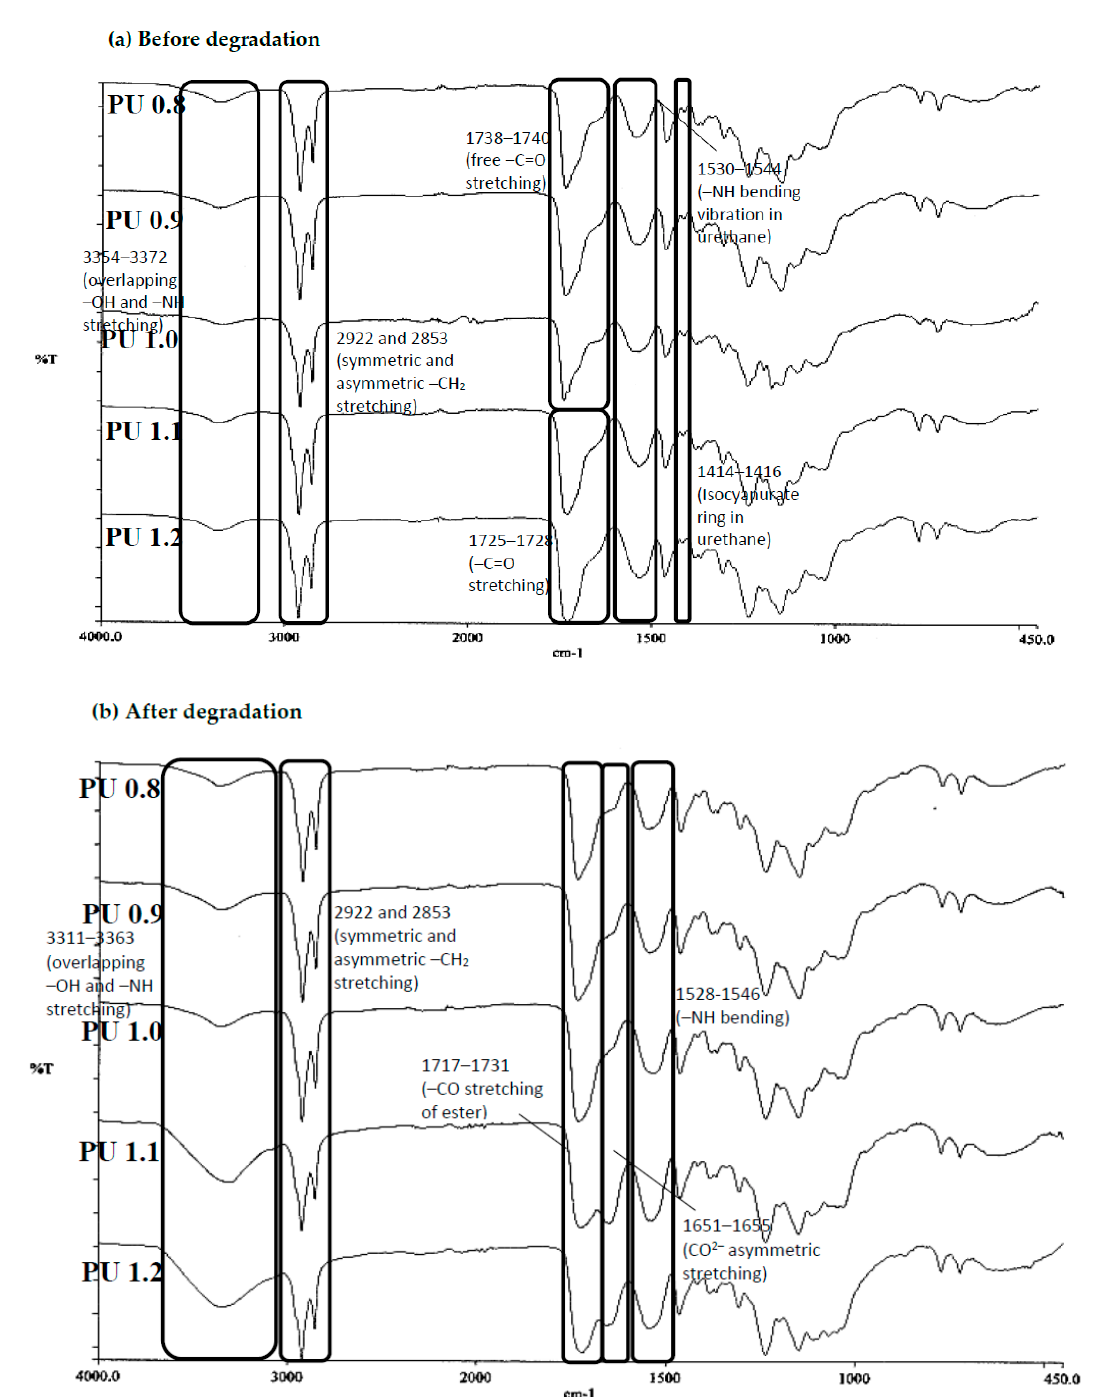
Figure 5. FTIR spectra of polyurethanes produced by di ff erent isocyanate indices ( a ) before and ( b ) after enzymatic degradation study. * PU 0.8, PU 0.9, PU 1.0, PU 1.1, PU 1.2 were prepared by reacting palm oil-based polyester polyol with IPDI at isocyanate index of 0.8, 0.9, 1.0, 1.1 and 1.2.